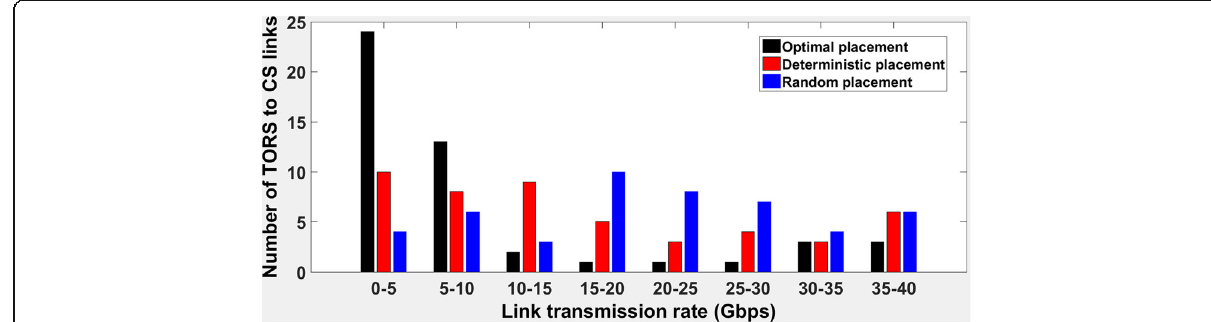
Fig. 9 Histogram of the number of TORS to CS links for optimal, deterministic and random placement of the jobs as a function of the link transmission rate for constant VM traffic